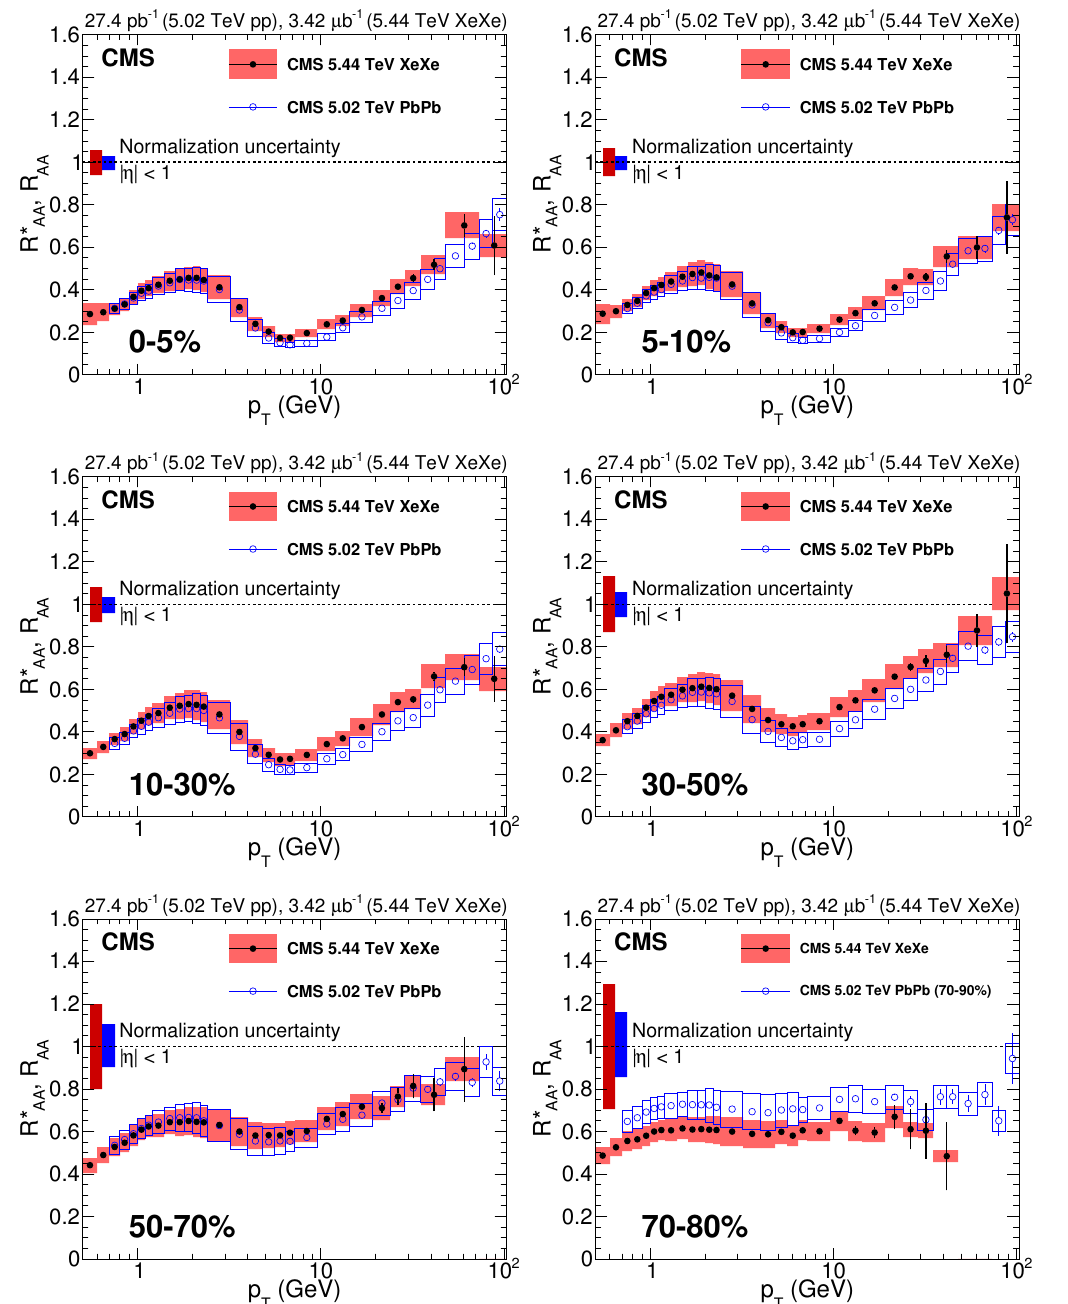
p for XeXe collisions at s = 5 : 44 TeV in six centrality AA NN